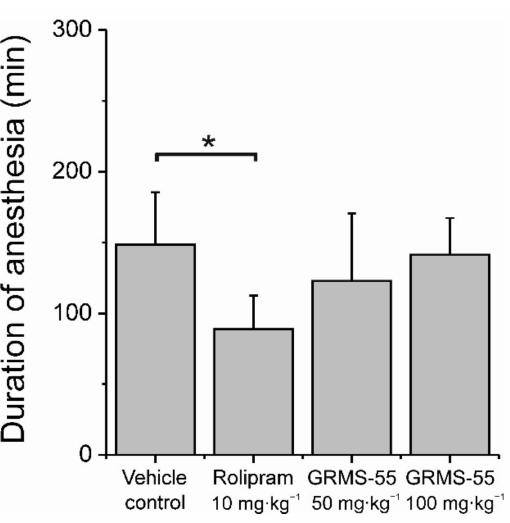
Figure 6. Influence of GRMS-55 administration on the duration of anesthesia induced by an α 2 - adrenoceptor agonist. Bars represent the mean (+SD) time of sleep in each group of mice ( n = 6); * p < 0.05, one-way ANOVA with Tukey’s HSD post-hoc test. In the same study, GRMS-55 did not affect the sleeping time at doses up to 100 mg · kg − 1 . These results indicate that GRMS-55 may possess a lower emetogenic potential than rolipram, which makes it a suitable candidate for further